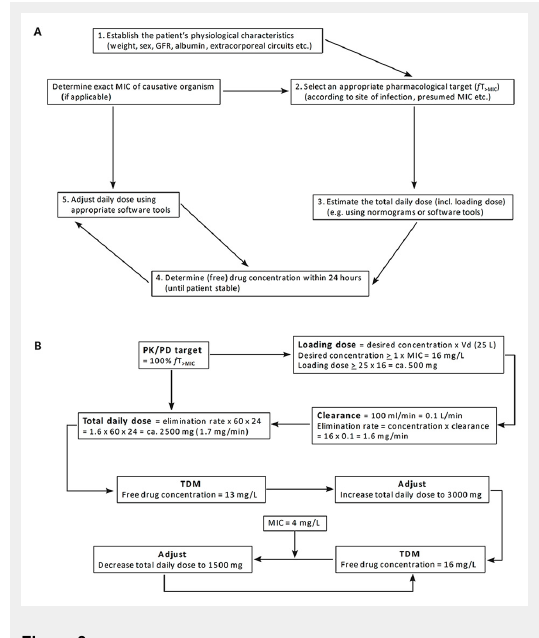
(A) Algorithm for personalised β-lactam dose optimisation in critically-ill patients. (B) Calculation of meropenem dose for empirical and definitive treatment of severe pulmonary sepsis caused by P. aeruginosa in a neutropenic fever patient (38 years old, 70 kg). The following parameters are assumed for this hypothetical calculation: presumed MIC for P. aeruginosa ≤16 mg/L (local surveillance data), calculated creatinine clearance of 100 ml/ min, treatment with vasoactive agents. Based on concept from Choi et al. [85]. GFR = glomerular filtration rate; MIC = minimal inhibitory concentration; PK/PD = pharmacokinetics/pharmacodynamics; f T >MIC = time that the free drug concentration is above the MIC; TDM = therapeutic drug monitoring; Vd = volume of